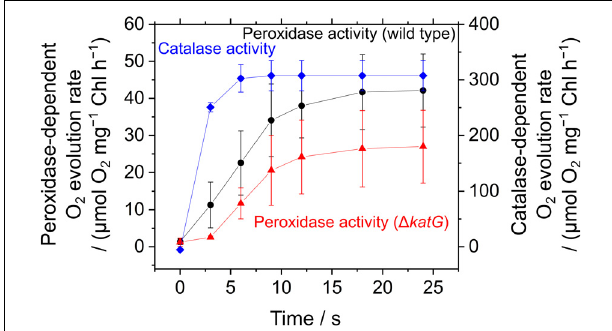
FIGURE 6 | Induction of O 2 evolution by exogenous H 2 O 2 through peroxidase and catalase activities in Synechococcus elongatus PCC 7942. Peroxidase-dependent O 2 evolution was measured in the presence of hydroxylamine (25 µ M) in phase β in the wild type (black circles) and the (cid:49) katG mutant (red triangles). Exogenous H 2 O 2 (50 µ M) was added at 0 s. Catalase-dependent O 2 evolution in the wild type (blue diamonds) was measured in the dark without adding hydroxylamine. Data are mean ± the standard deviation of three experiments (technical replicates).